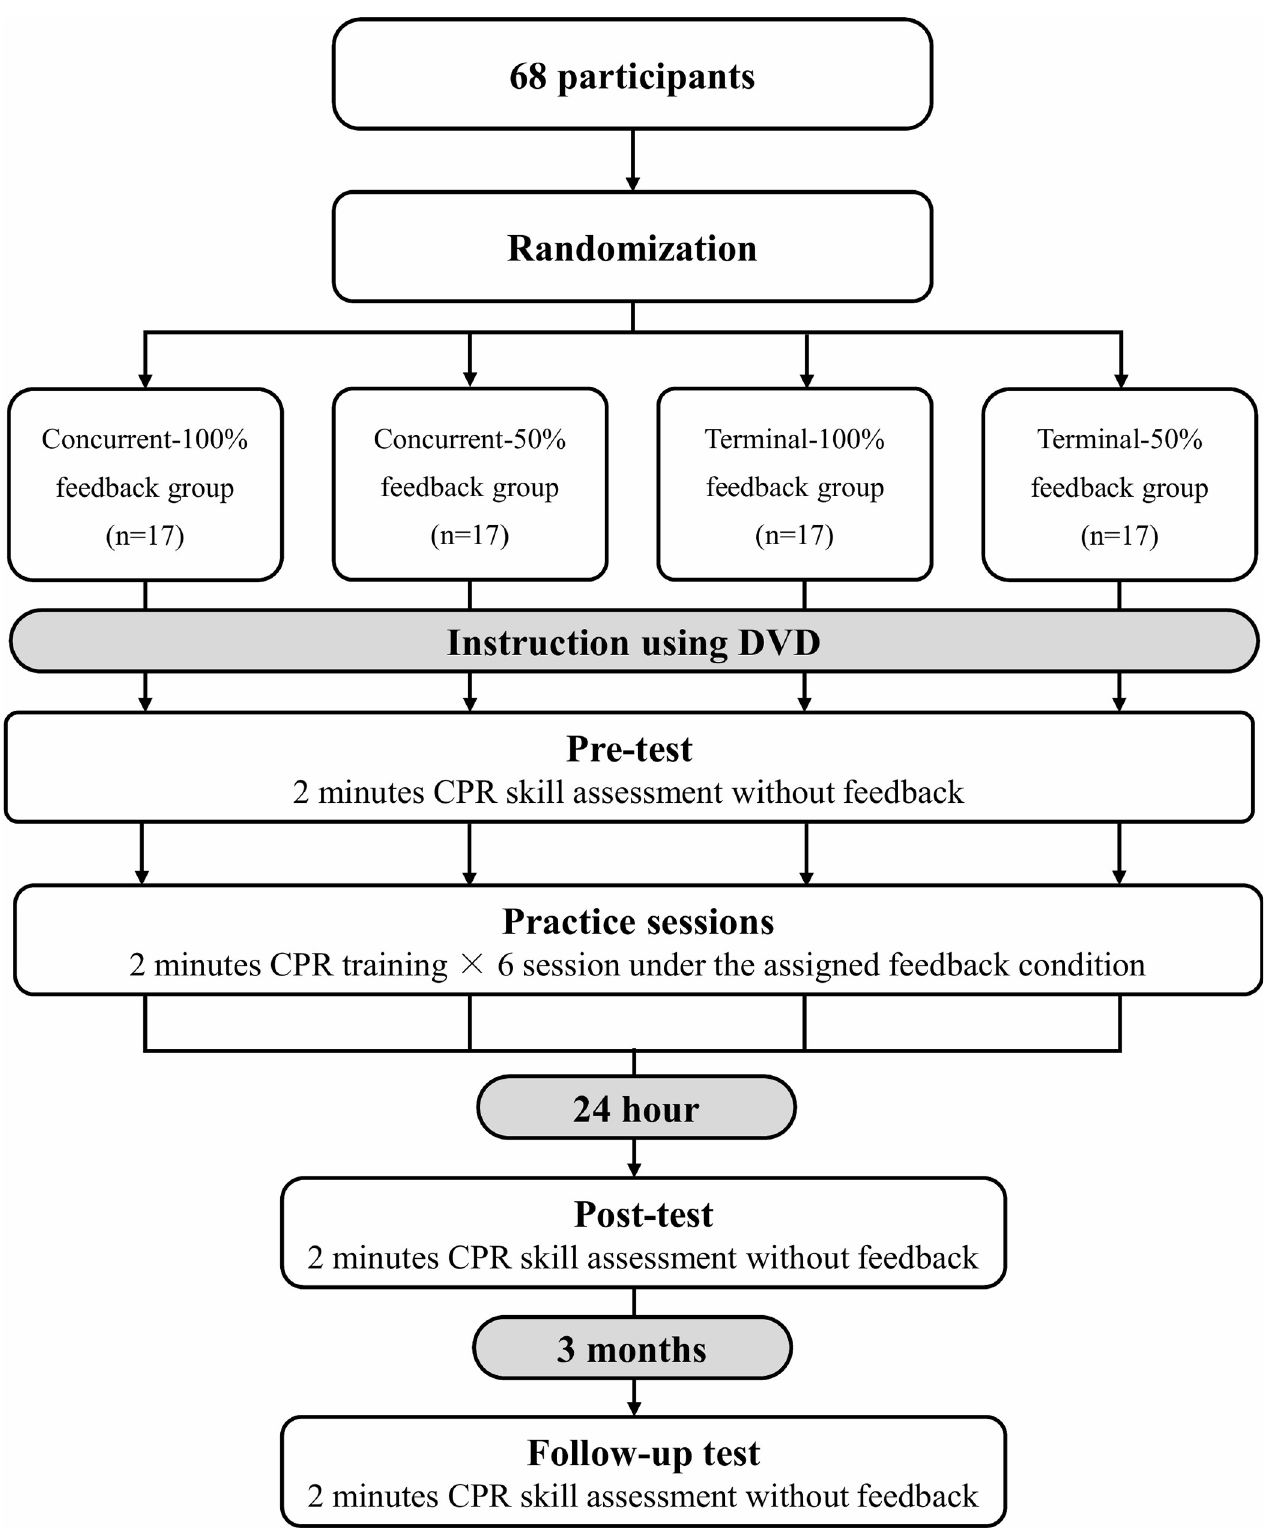
Fig 2. Experimental design to confirm the influence of feedback timing and feedback frequency on acquisition of CPR skills. To confirm the participant’s skill levels before practice in the pre-test, all the participants conducted 2-minutes of CPR without the receipt of feedback. In the practice sessions, the